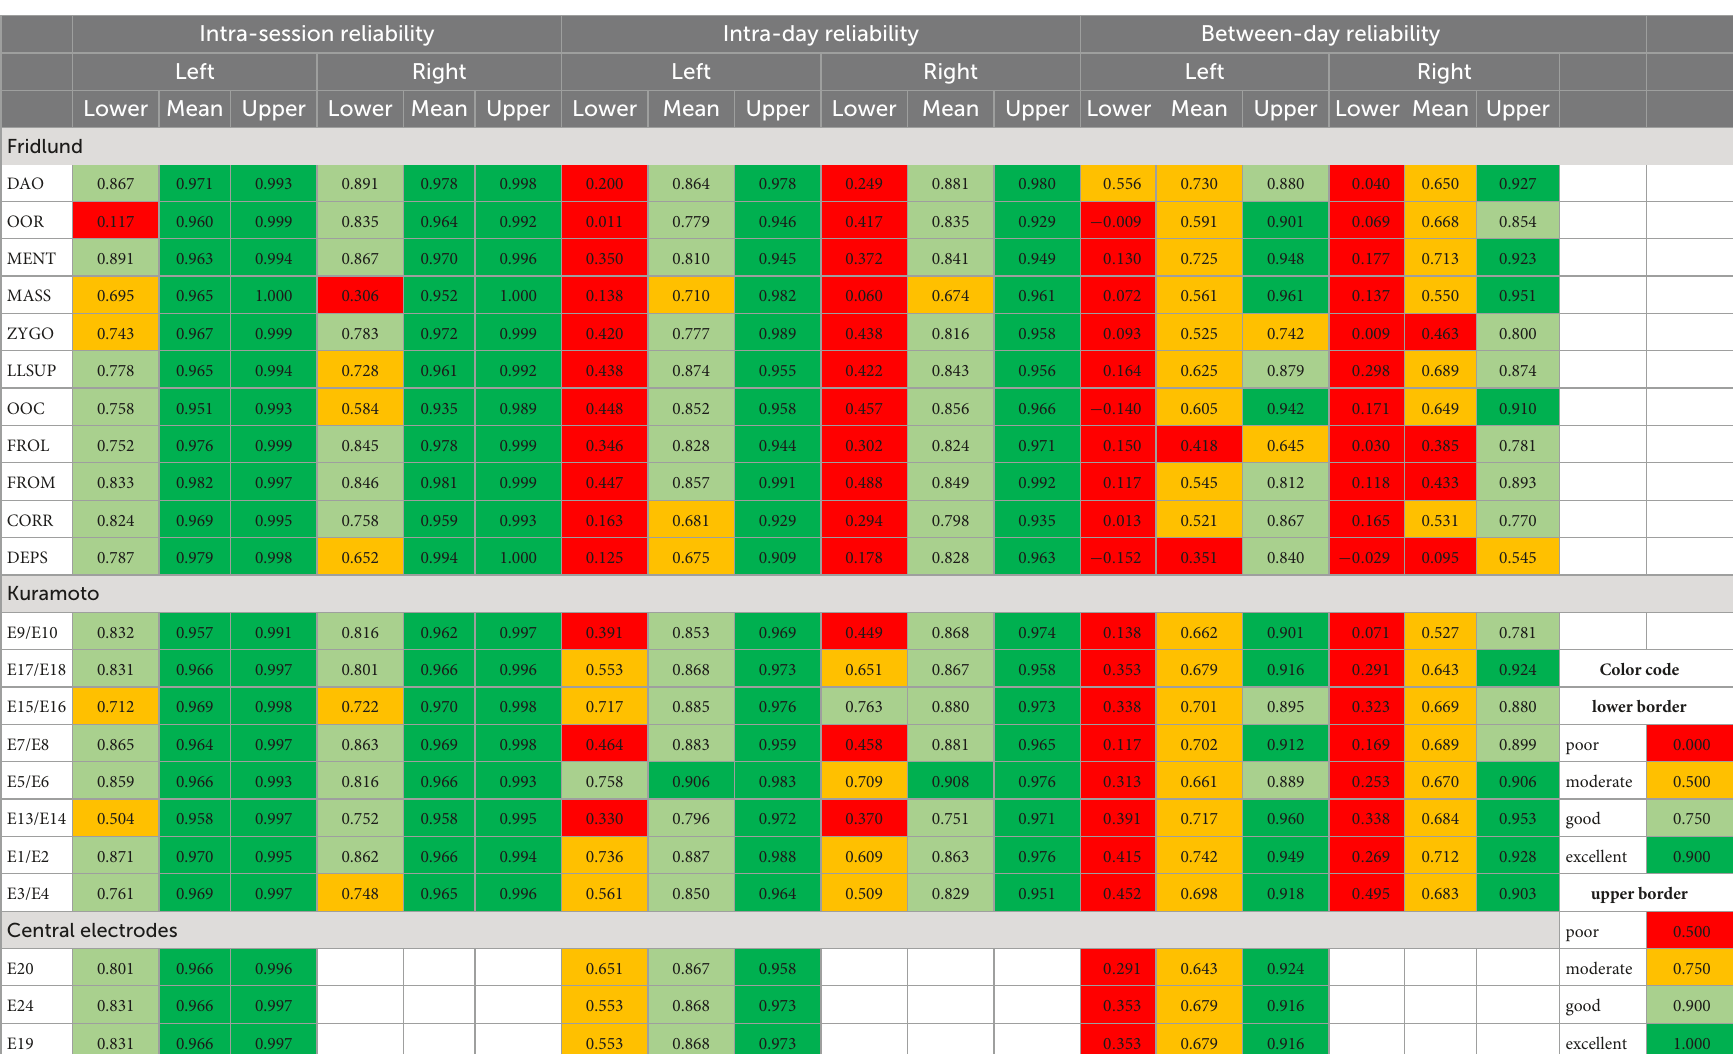
TABLE 1 Intraclass correlation coefficient (ICC) statistics: Test and re-test reliability of the surface EMG recordings from the different facial